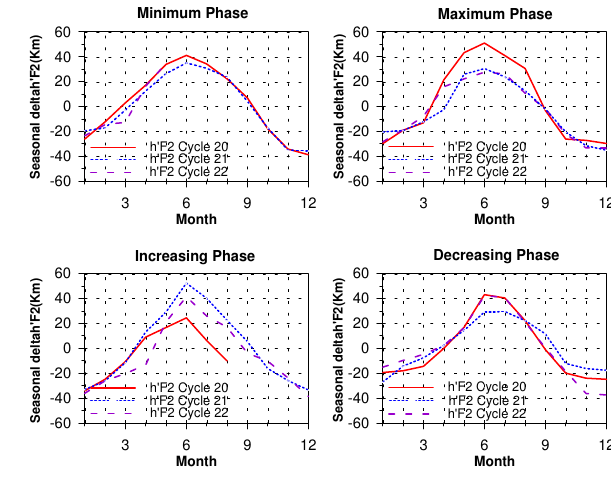
Fig. 6. Similar to Fig. 4 for h 0 F2.